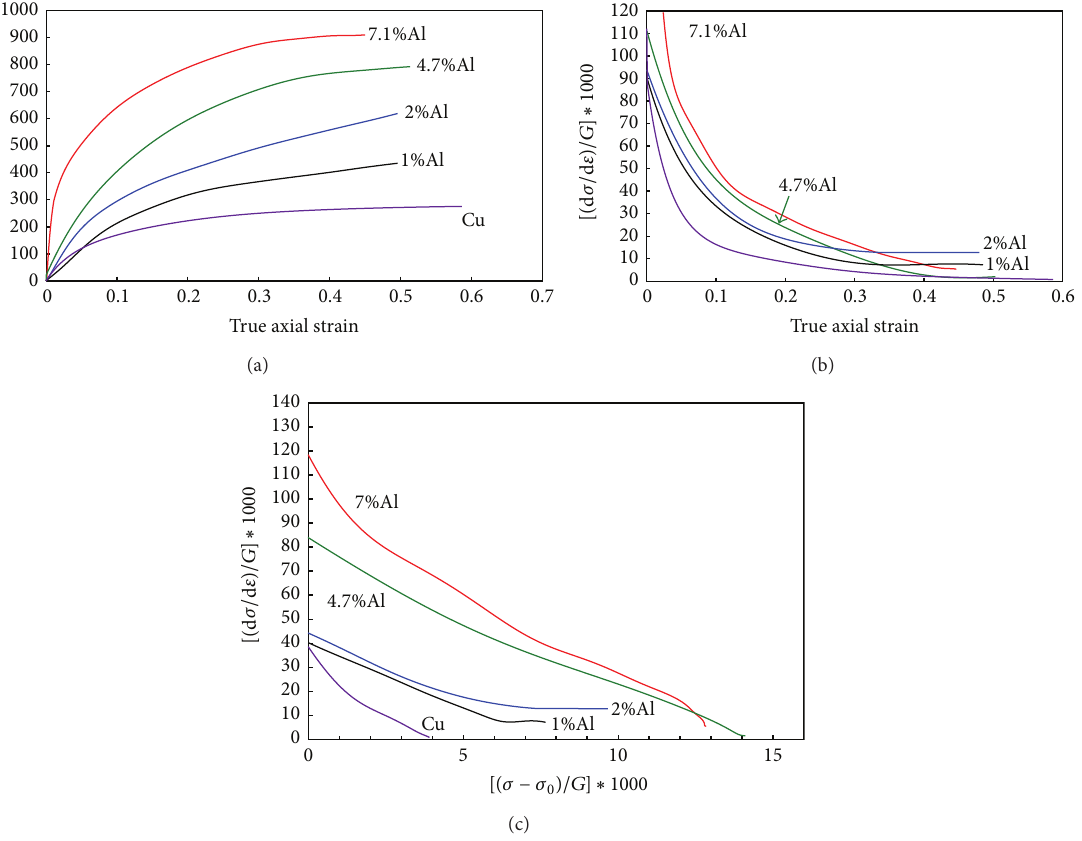
Figure2:(a)Trueaxialstress-trueaxialstrainresponseforallmaterialswithanaveragegrainsizeof15 𝜇 m,testedinplanestraincompression. Normalized strain hardening rate versus true strain in (b) and versus normalized stress parameter in (c) for all materials displayed in part (a).